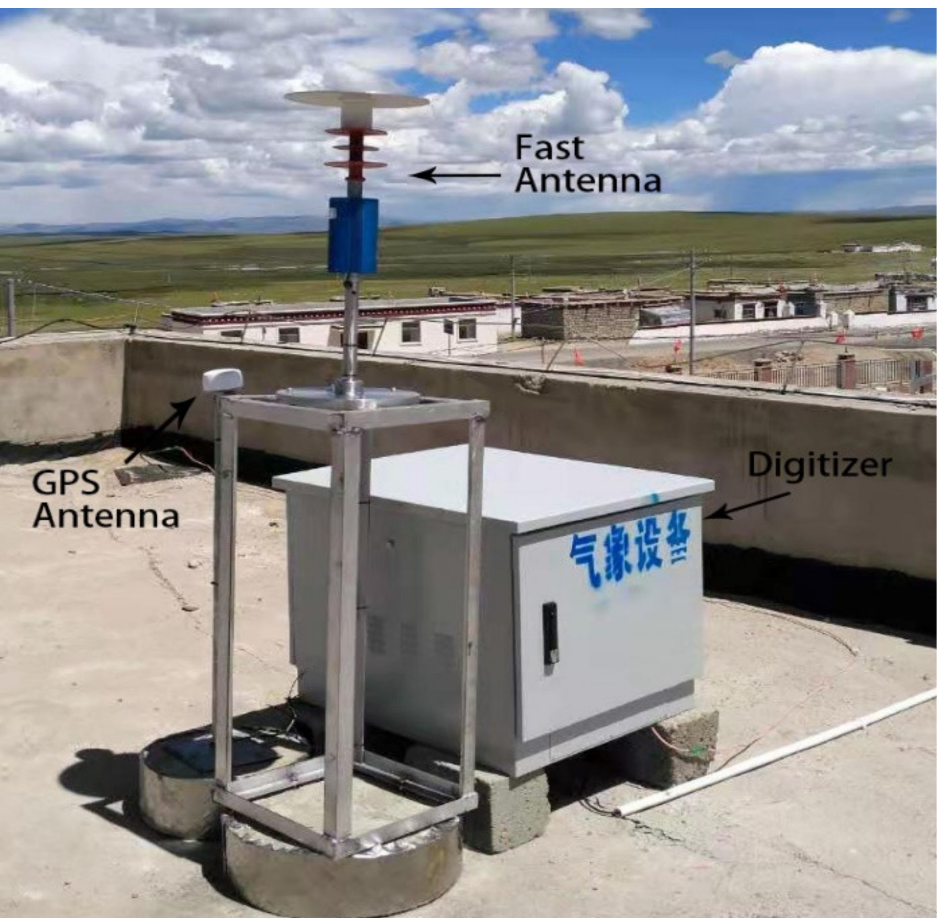
Figure 2. Pictures of a Low-frequency E-field Detection Array substation (Digitizer, Fast antenna, and GPS